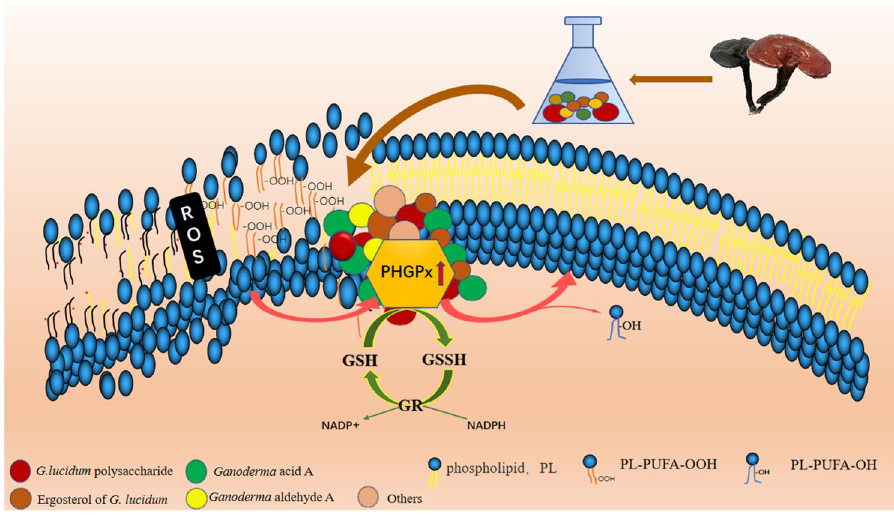
Figure 7. Schematic diagram of anti-aging mechanism of G. lucidum aqueous extract based on